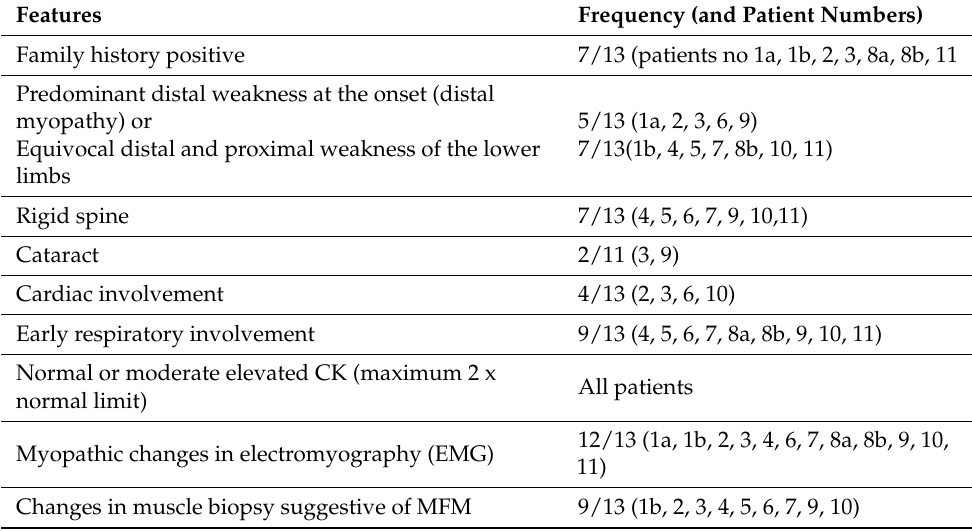
Table 1. Red flags characteristic for myofibrillar myopathies (MFM) and their frequency in patients. CK: creatine